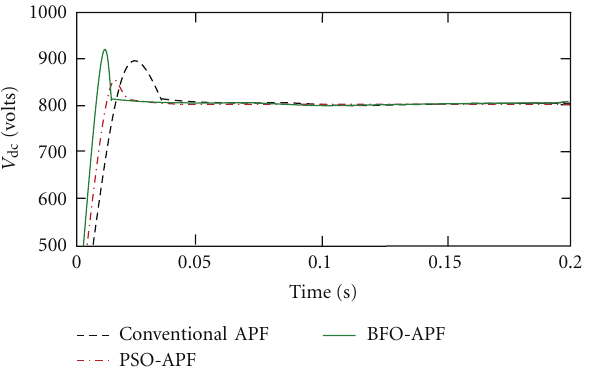
Figure 12: Convergence of V dc with ideal supply. Figure 13: Convergence of V dc with unbalanced supply.